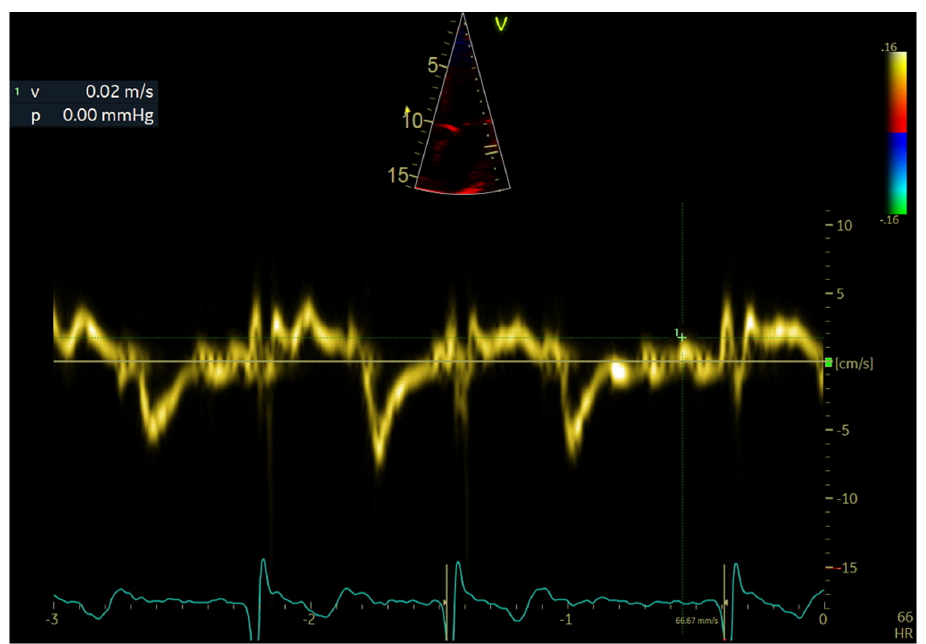
Figure 1. Left atrial wall motion velocity measurement. LAWMV of 5 cm/s towards the probe.